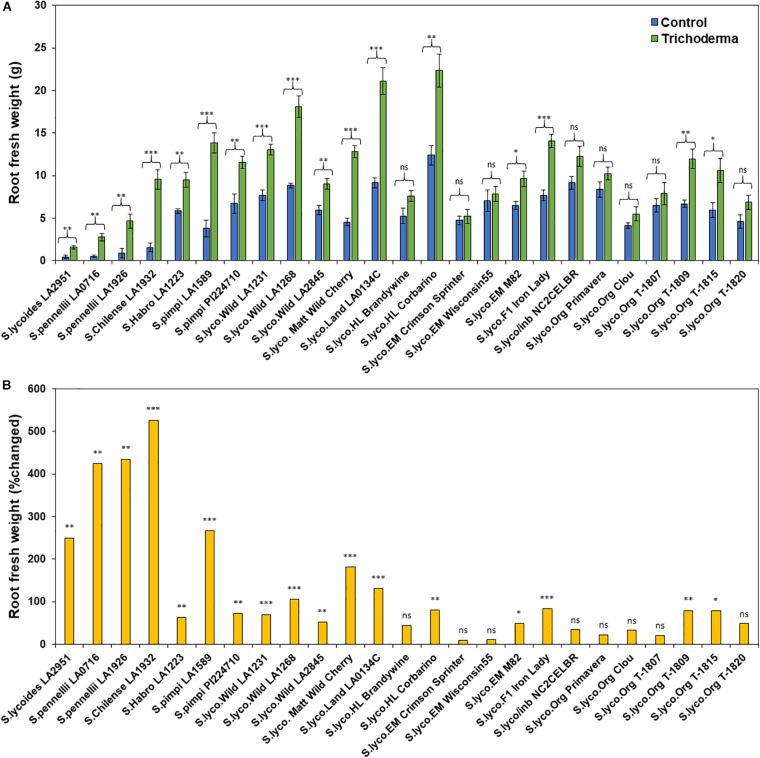
Effect of Trichoderma treatment on (A) root biomass (g) in a diverse set of tomato genotypes. Graph (B) represents the percentage in root biomass changed by Trichoderma treatment in comparison with the control treatment. Asterisks indicate significant differences in root biomass in the Trichoderma-treated versus control plants using the Student’s t-test at a ∗P ≤ 0.05, ∗∗P ≤ 0.01 and ∗∗∗P ≤ 0.001. Bars represent the standard error.